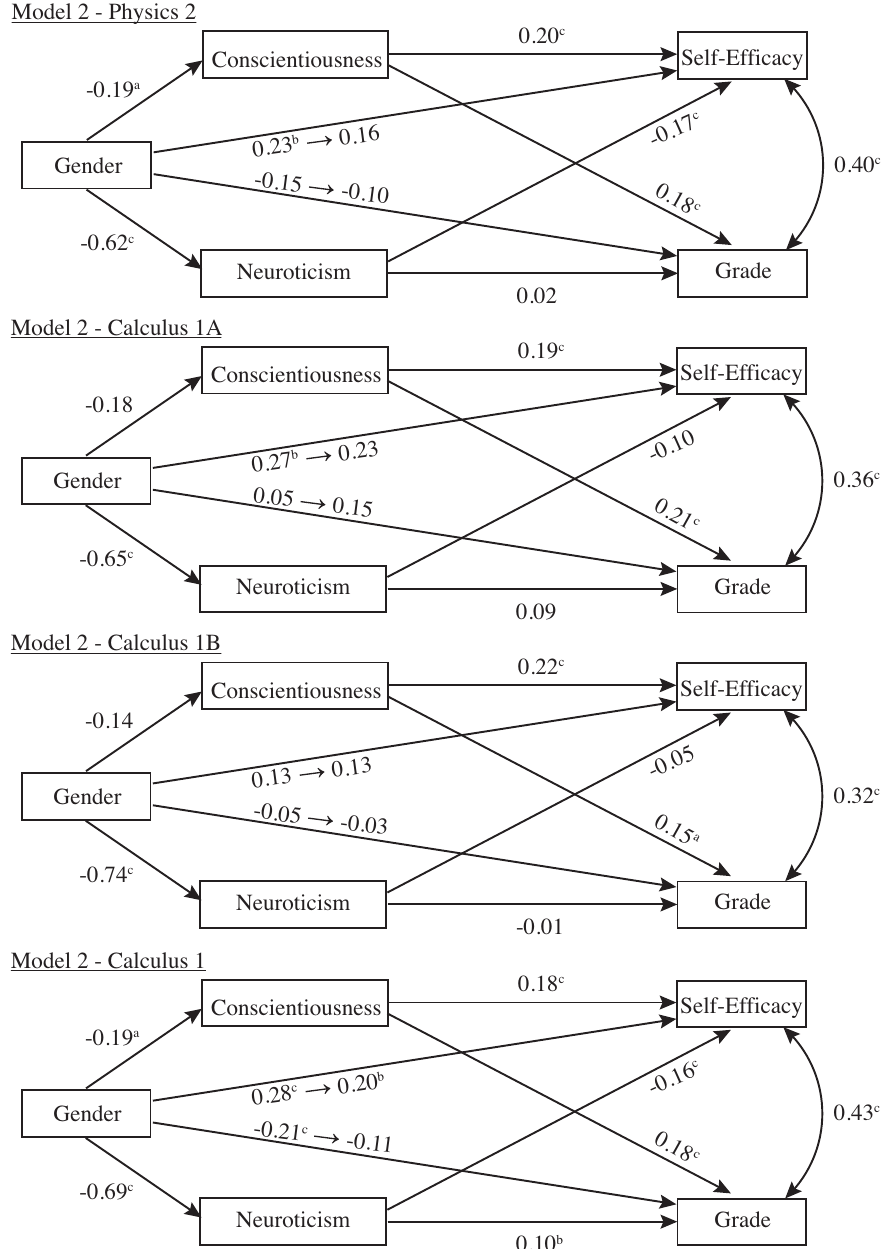
FIG. 5. Model 2 path models showing the relation of gender, personality, and self-efficacy for students in Physics 2, Calculus 1A, Calculus 1B, and Calculus 1. The number on each path is the value of the regression coefficient. The notation # 1 → # 2 shows the change in the coefficient before ( # 1 ) and after ( # 2 ) the addition of the mediating variables. Compare the figure with Fig. 2 for the symbolic variable related to each number. Note: “ a ” denotes p < 0 . 05 , “ b ” p < 0 . 01 , and “ c ” p < 0 . 001